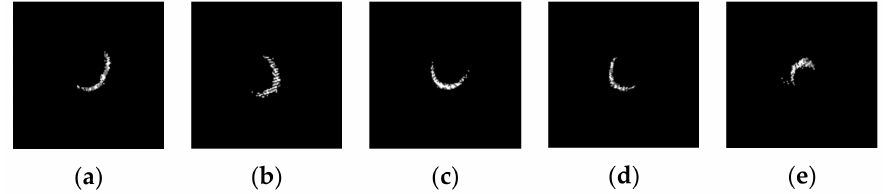
Figure 7. Binary images of five slices of plot 3 of single-scan mode with height of 1.25–1.35 m, gray scale threshold of 1. ( a ) Tree 2; ( b ) Tree 7; ( c ) Tree 21; ( d ) Tree 36; ( e ) Tree